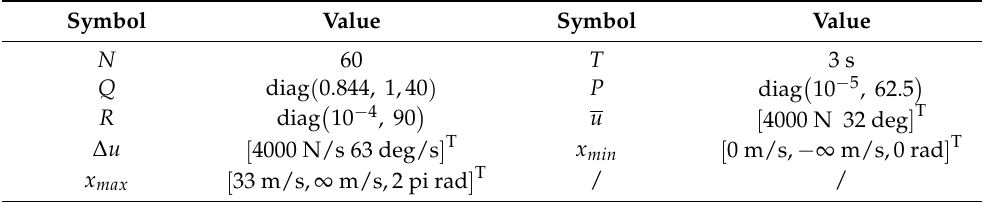
Table 2. Parameters of NMPC motion planner.